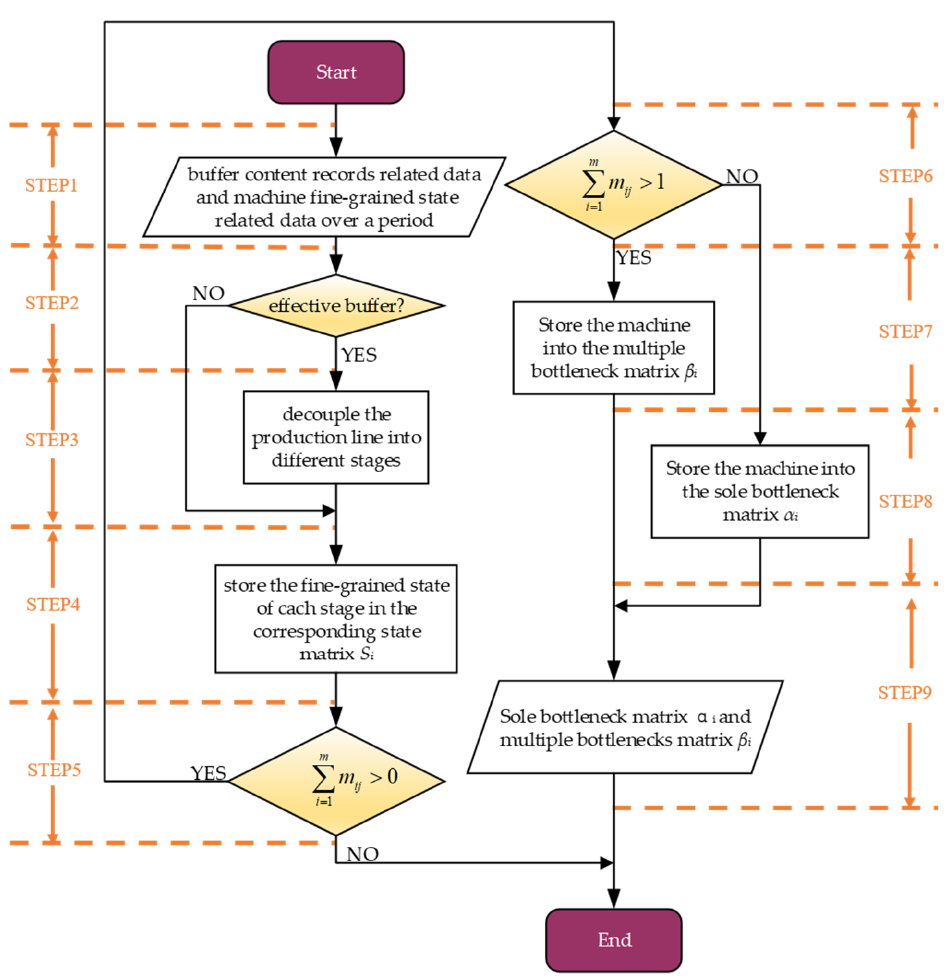
Figure 1. DBI-BS method flowchart.